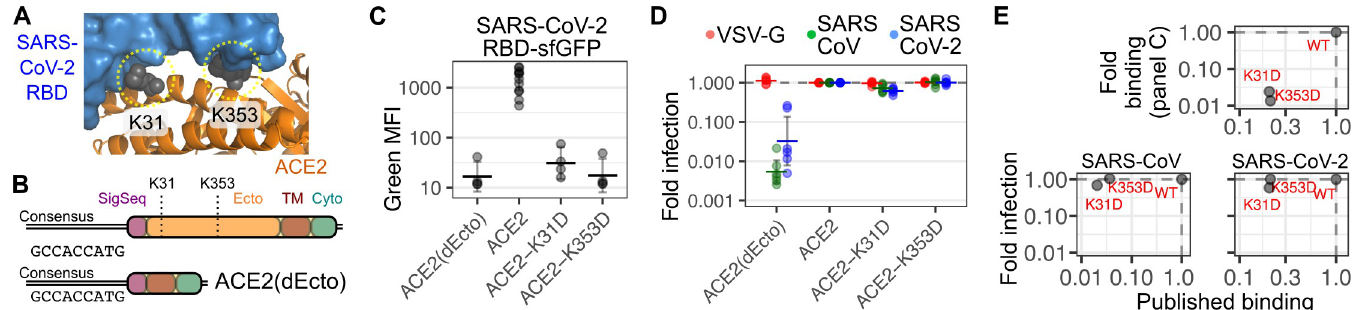
Fig 2. ACE2 variant expressed at high abundance levels. A) The location of ACE2 (orange) K31 and K353 residues (grey) in the interface with SARS-CoV-2 RBD (blue); with the three-dimensional structure provided by PDB 6M17. B) Schematic showing the coding region of the ACE2 expression construct, as well as the dEcto negative control construct lacking the entire extracellular domain. C) ACE2 variant constructs encoding the consensus Kozak, stained with SARS-CoV-2 RBD-sfGFP. n = 4 or more, error bars denote 95% confidence intervals. D) Pseudovirus infection rates of ACE2 variants encoding the consensus Kozak, normalized to cells encoding WT ACE2. n = 6, error bars denote 95% confidence intervals. E) Scatterplots depicting pseudovirus infection or SARS-CoV-2 RBD-sfGFP staining of cells encoding consensus Kozak ACE2 preceding WT, K31D, or K353D ACE2, compared to published binding studies with SARS-CoV or SARS-CoV-2